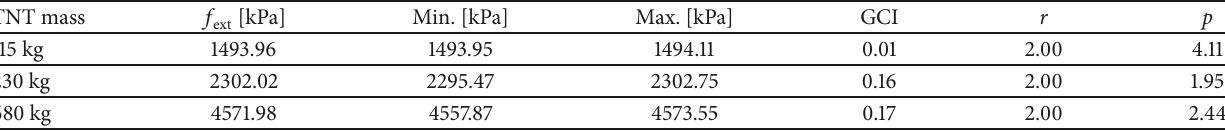
Table 9: Extrapolated pressure values ( 𝑓 ext ) and GCI for axisymmetric simulation.